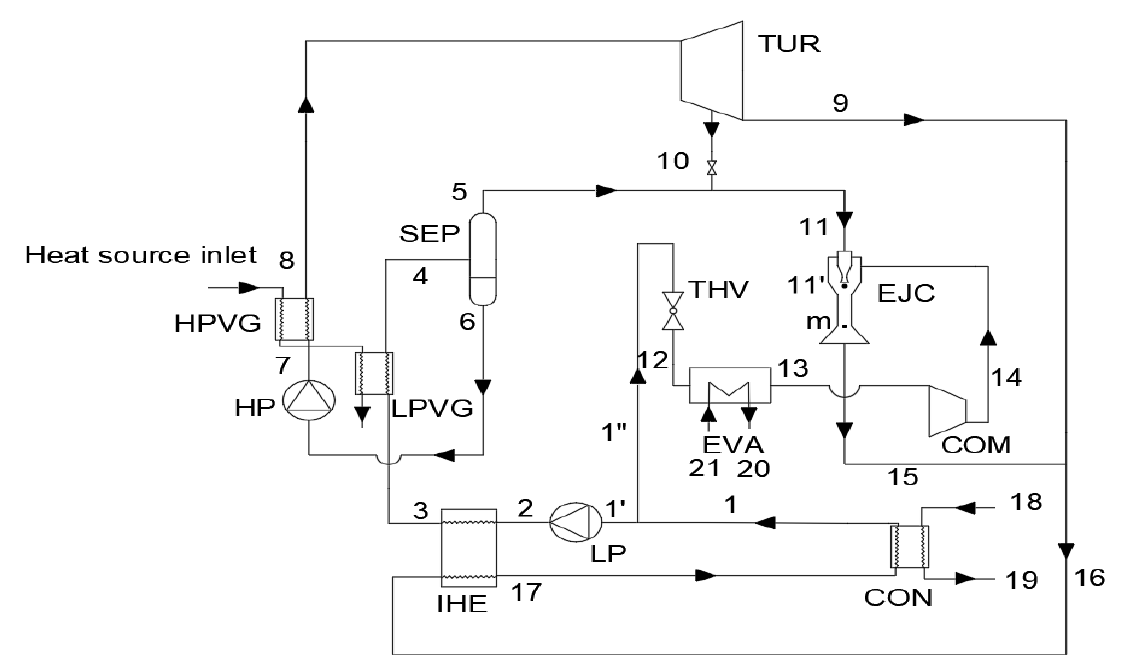
Figure 1. The cycle diagram of the